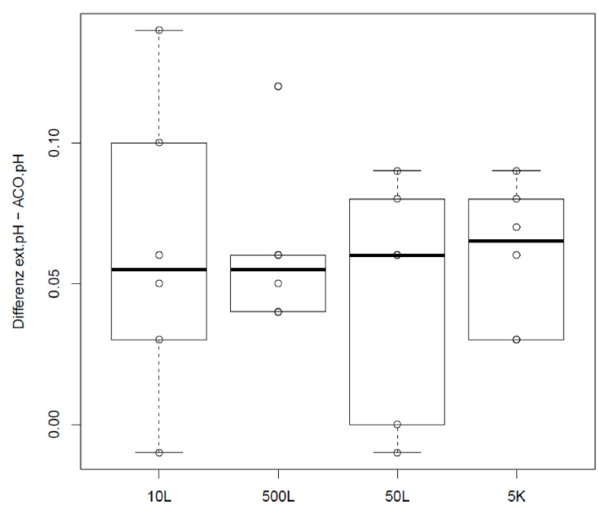
Figure 5. Difference of sample-based offline values and pH calculated from the exhaust carbon dioxide concentration depending on scale.